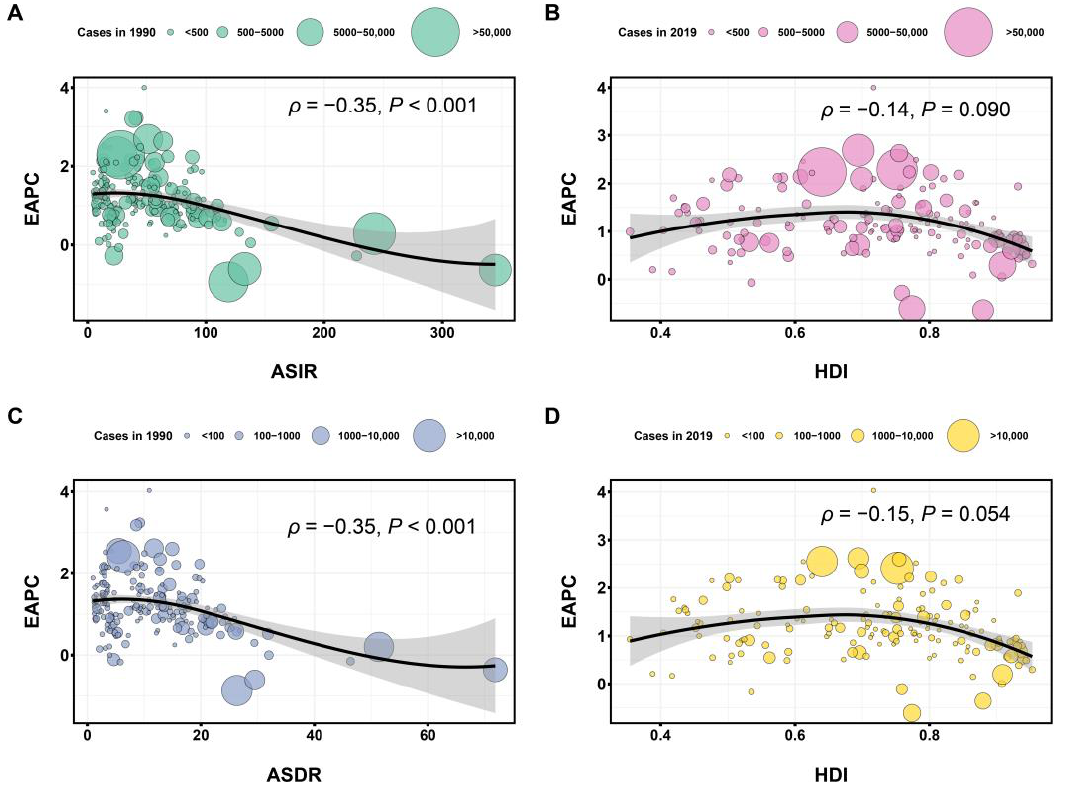
Figure 5. The correlation between EAPC and ASR (per 100,000) in 1990, as well as EAPC and HDI of PCOS in 2019. ( A ) Correlation between EAPC and ASIR (per 100,000) in 1990. ( B ) Correlation between EAPC and HDI in incidence in 2019. ( C ) Correlation between EAPC and ASDR (per 100,000) in 1990. ( D ) Correlation between EAPC and HDI in DALYs in 2019. Each circle represents a country or region, and the circle size positively correlates with the number of PCOS cases in that country or region. EAPC, estimated annual percentage change; ASR, age-standardized rates; HDI, human development index; PCOS, polycystic ovary syndrome; ASIR, age-standardized incidence rate; ASDR, age-standardized disability-adjusted life years rate.